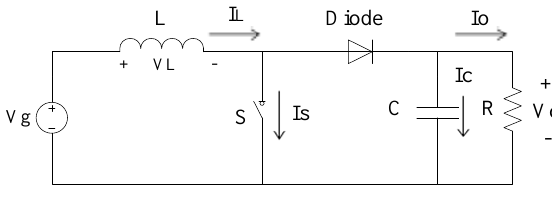
Figure 3. Topology of boost converter.